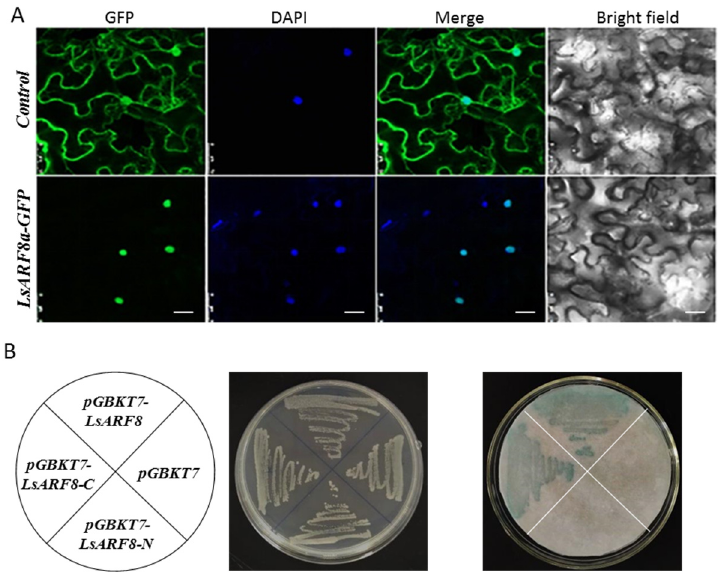
Figure 8. LsARF8a encodes a transcriptional activator. ( A ) Subcellular localization of LsARF8a-GFP fusion proteins. Indicated constructs were agro-infiltrated into N. benthamiana leaves, and the subcellular localization of GFP alone (upper panel) or LsARF8a-GFP fusion proteins (lower panel) was analyzed by confocal laser-scanning microscopy. Images of representative leaf epidermal cells were taken 48 h after agro-infiltration. The photographs (left to right): bright field, GFP fluorescence, DAPI fluorescence, and merge. Bar = 20 µ m. ( B ) Transcriptional activity analysis of LsARF8a in yeast cells. pGBKT7-LsARF8a , pGBKT7- LsARF8a-N (1–385 AA), pGBKT7-LsARF8a-C (386–799 AA), and pGBK&7 vector were transformed into yeast strain AH109 (left); the transformants grew well